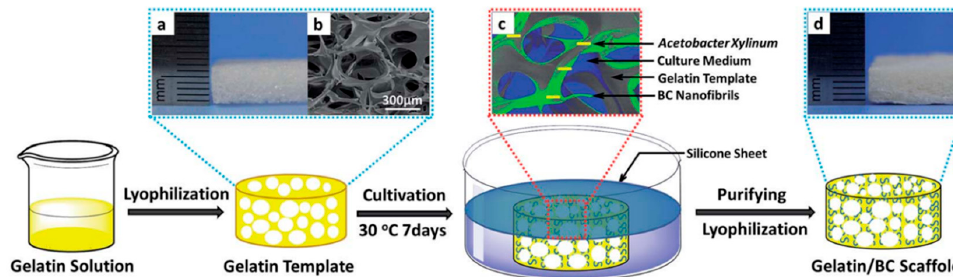
Figure 5. Schematic representation of GEL-BC by template synthesis method: ( a ) digital photograph image of GEL microporous template; ( b ) SEM image; ( c ) BC nanofibrils formed by biosynthesis method using G. Xylinus in GEL microporous template; ( d ) digital photograph image of GEL-BC scaffold. Reprinted with permission [102]. Copyright 2016 Royal Society of Chemistry.